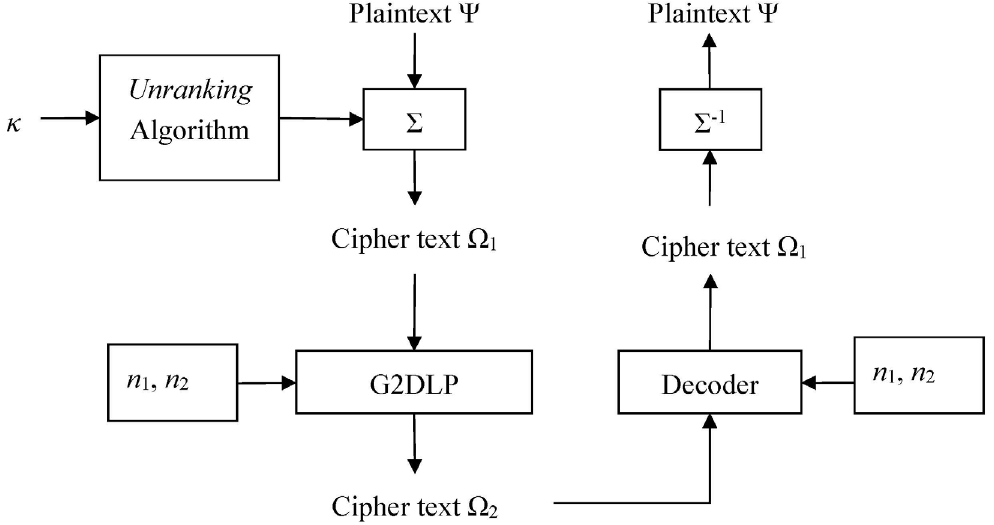
Figure 3. Encryption-Decryption